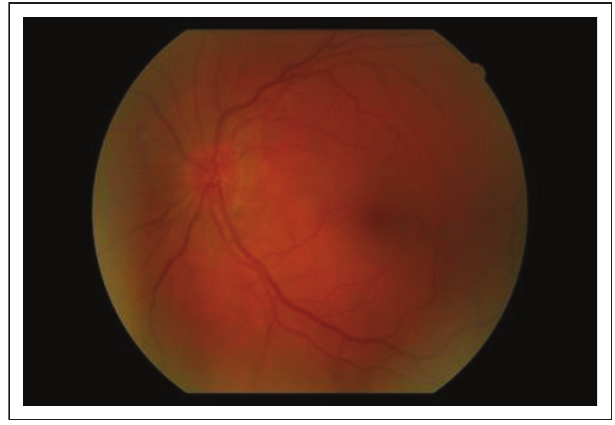
FIGURE 2: Left eye fundus photograph of patient with ethambutol toxic optic